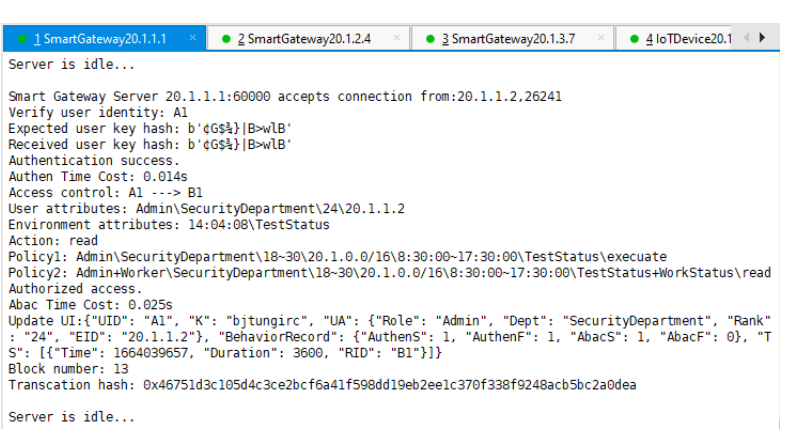
Figure 10. SG A performs access control process and the result is authorization success.